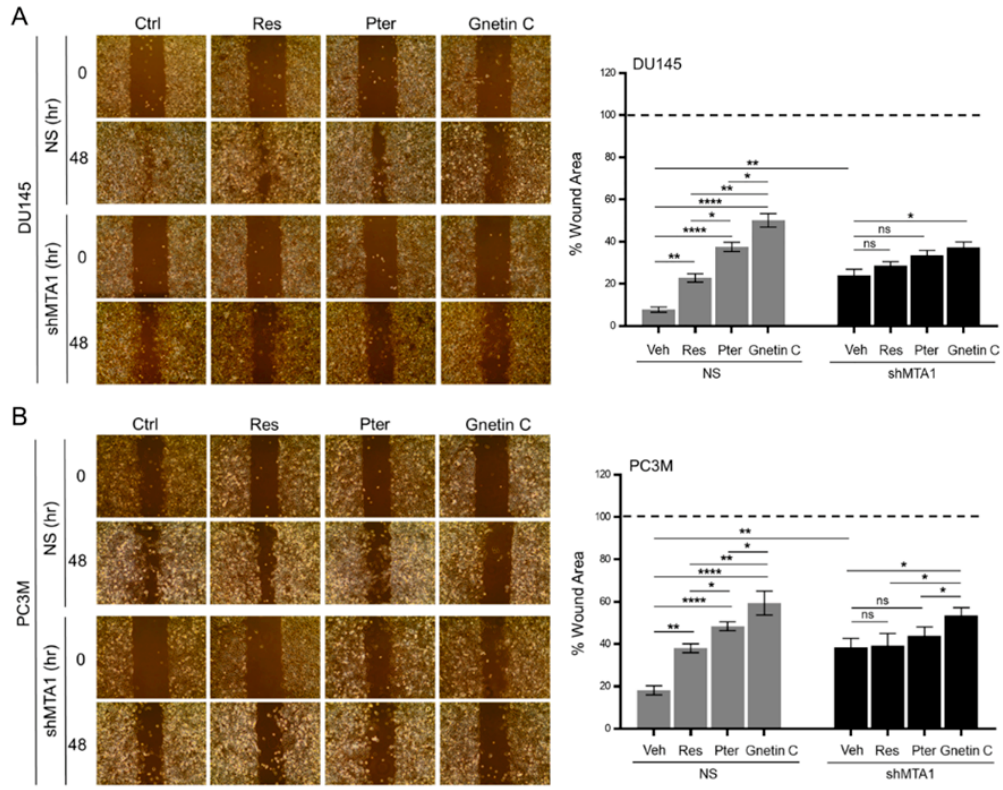
Figure 4. Gnetin C reduces the MTA1-mediated motility of PCa cells more potently than resveratrol and pterostilbene. ( A , B ) Representative images showing the migration ability of DU145 and PC3M MTA1 expressing (NS) and MTA1 knockdown (shMTA1) cells after treatment with 1 µ M of Res, Pter, and Gnetin C for 48 h. Right , Quantifications of wound widths as a percentage of wound area using ImageJ software is shown for each cell line. Data represent the mean ± SEM of six separate wounds and three independent experiments. * p < 0.05; ** p < 0.01; *** p < 0.001; **** p < 0.0001 (one-way ANOVA).